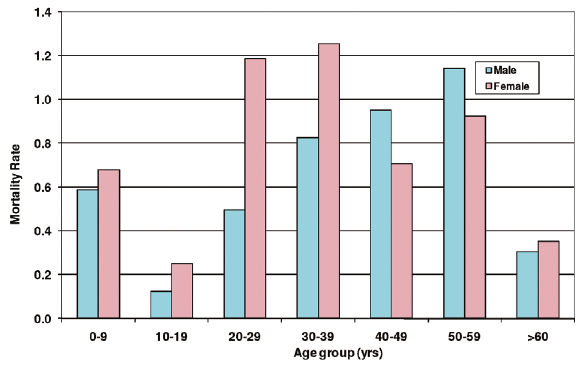
Figure 2 - Mortality rate by sex and age group (per 100,000 inhabitants) - São Paulo state - Brazil, as of 5th